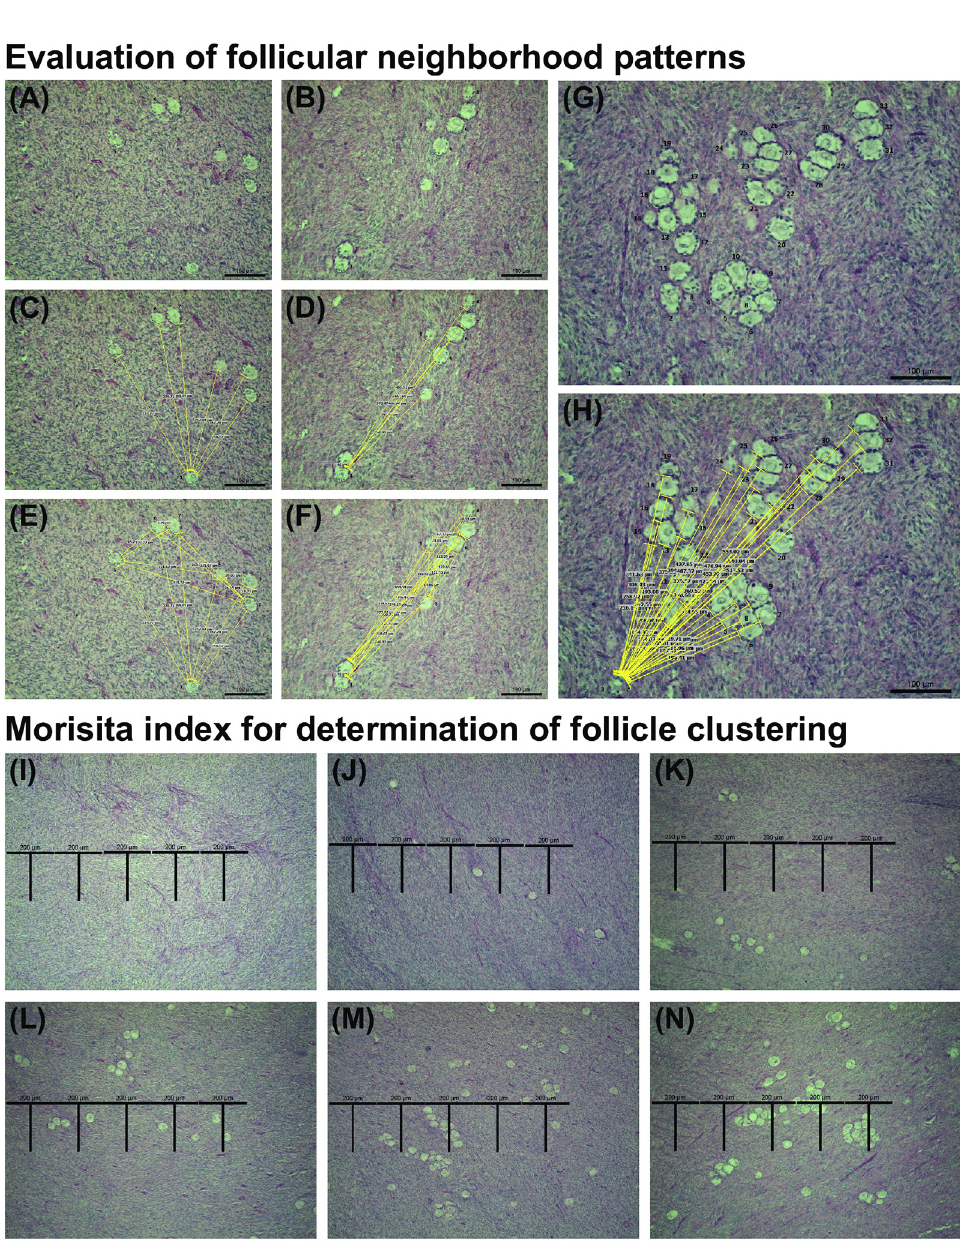
Fig 2. Images of experimental procedures performed to assess the preantral follicle neighborhood and clustering patterns. (A–H) Representative images used for determination of follicular neighborhood patterns are shown. For neighborhood pattern assessment, random fields were imaged, and (A, B, G) follicles within each image were numbered, and classified according to morphology and developmental stage. Next, (C, D, H) the distances from the first follicle (labelled with the number “1”) were measured, and subsequently, (E, F) the distances between all follicles within the field were measured. Scale bars = 100 μ m, magnification = 20 × . (I–N) Representative images of randomly generated fields depicting progressive lower to higher clustering patterns are also shown. To assess preantral follicle clustering, the fields were overlaid with 5 consecutive 200 x 200 μ m “T” plots, the number of follicles in each plot were counted, and the clustering index was calculated. Scale bars = 200 μ m, magnification = 10 ×